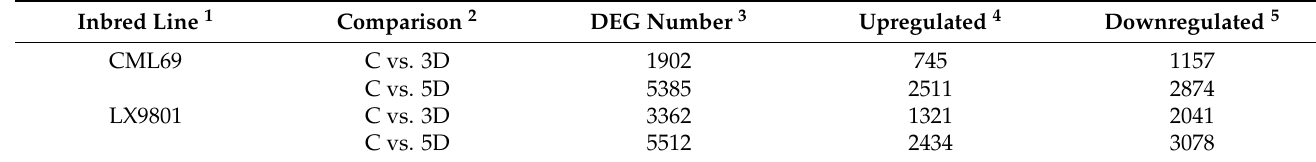
Table 1. Expression patterns of the 10,084 DEGs by inbred line and drought stress stage. Inbred Line